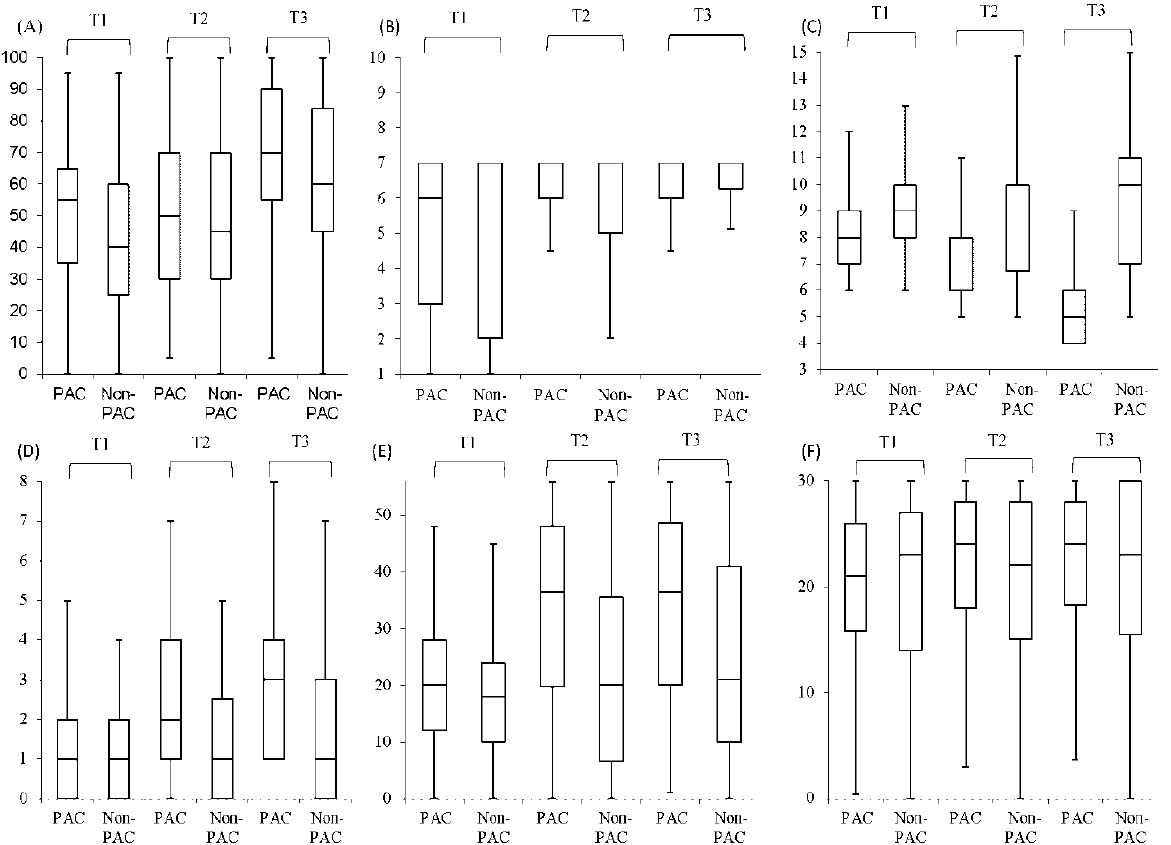
Figure 2. Comparison of box plot of all function status measures between post-acute care (PAC) group ( n = 273) and non-PAC group ( n = 273) before and after rehabilitation. The box plot indicates the interquartile range; the line, the median; the error bars, 95% confidence intervals (95% CIs). ( A ) BI, Barthel Index ( B ) FOIS, Functional Oral Intake Scale ( C ) EQ5D, EuroQoL Quality of Life Scale ( D ) IADL, Instrumental Activities of Daily Living Scale ( E ) BBS, Berg Balance Scale ( F ) MMSE, Mini-mental State Examination. T1: before rehabilitation; T2: 12th week after rehabilitation; T3: 1st year after rehabilitation. Table 2. Comparison of functional status between PAC group ( n = 273) and non-PAC group ( n = 273) before and after rehabilitation.